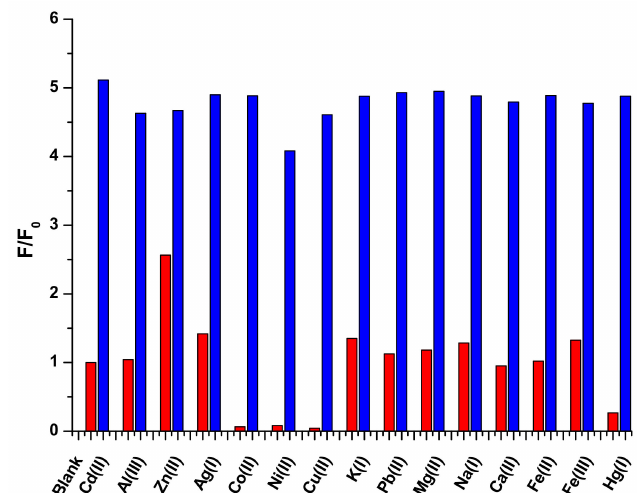
Figure 7. Metal-ion selectivity of 2b (10 µ M) in PBS buffer (10 mM, pH 7.2) containing 50% MeOH. The red bars represent the F/F 0 values for 2b + 2 equiv. of each metal ion, whereas the blue bars represent F/F 0 values for 2b + 2 equiv. of each metal ion + 2 equiv. of Cd 2+ ; F 0 : emission intensity of 2b ; F: emission intensity of 2b in the presence of 2 equiv. of each cation or each cation + Cd 2+ .